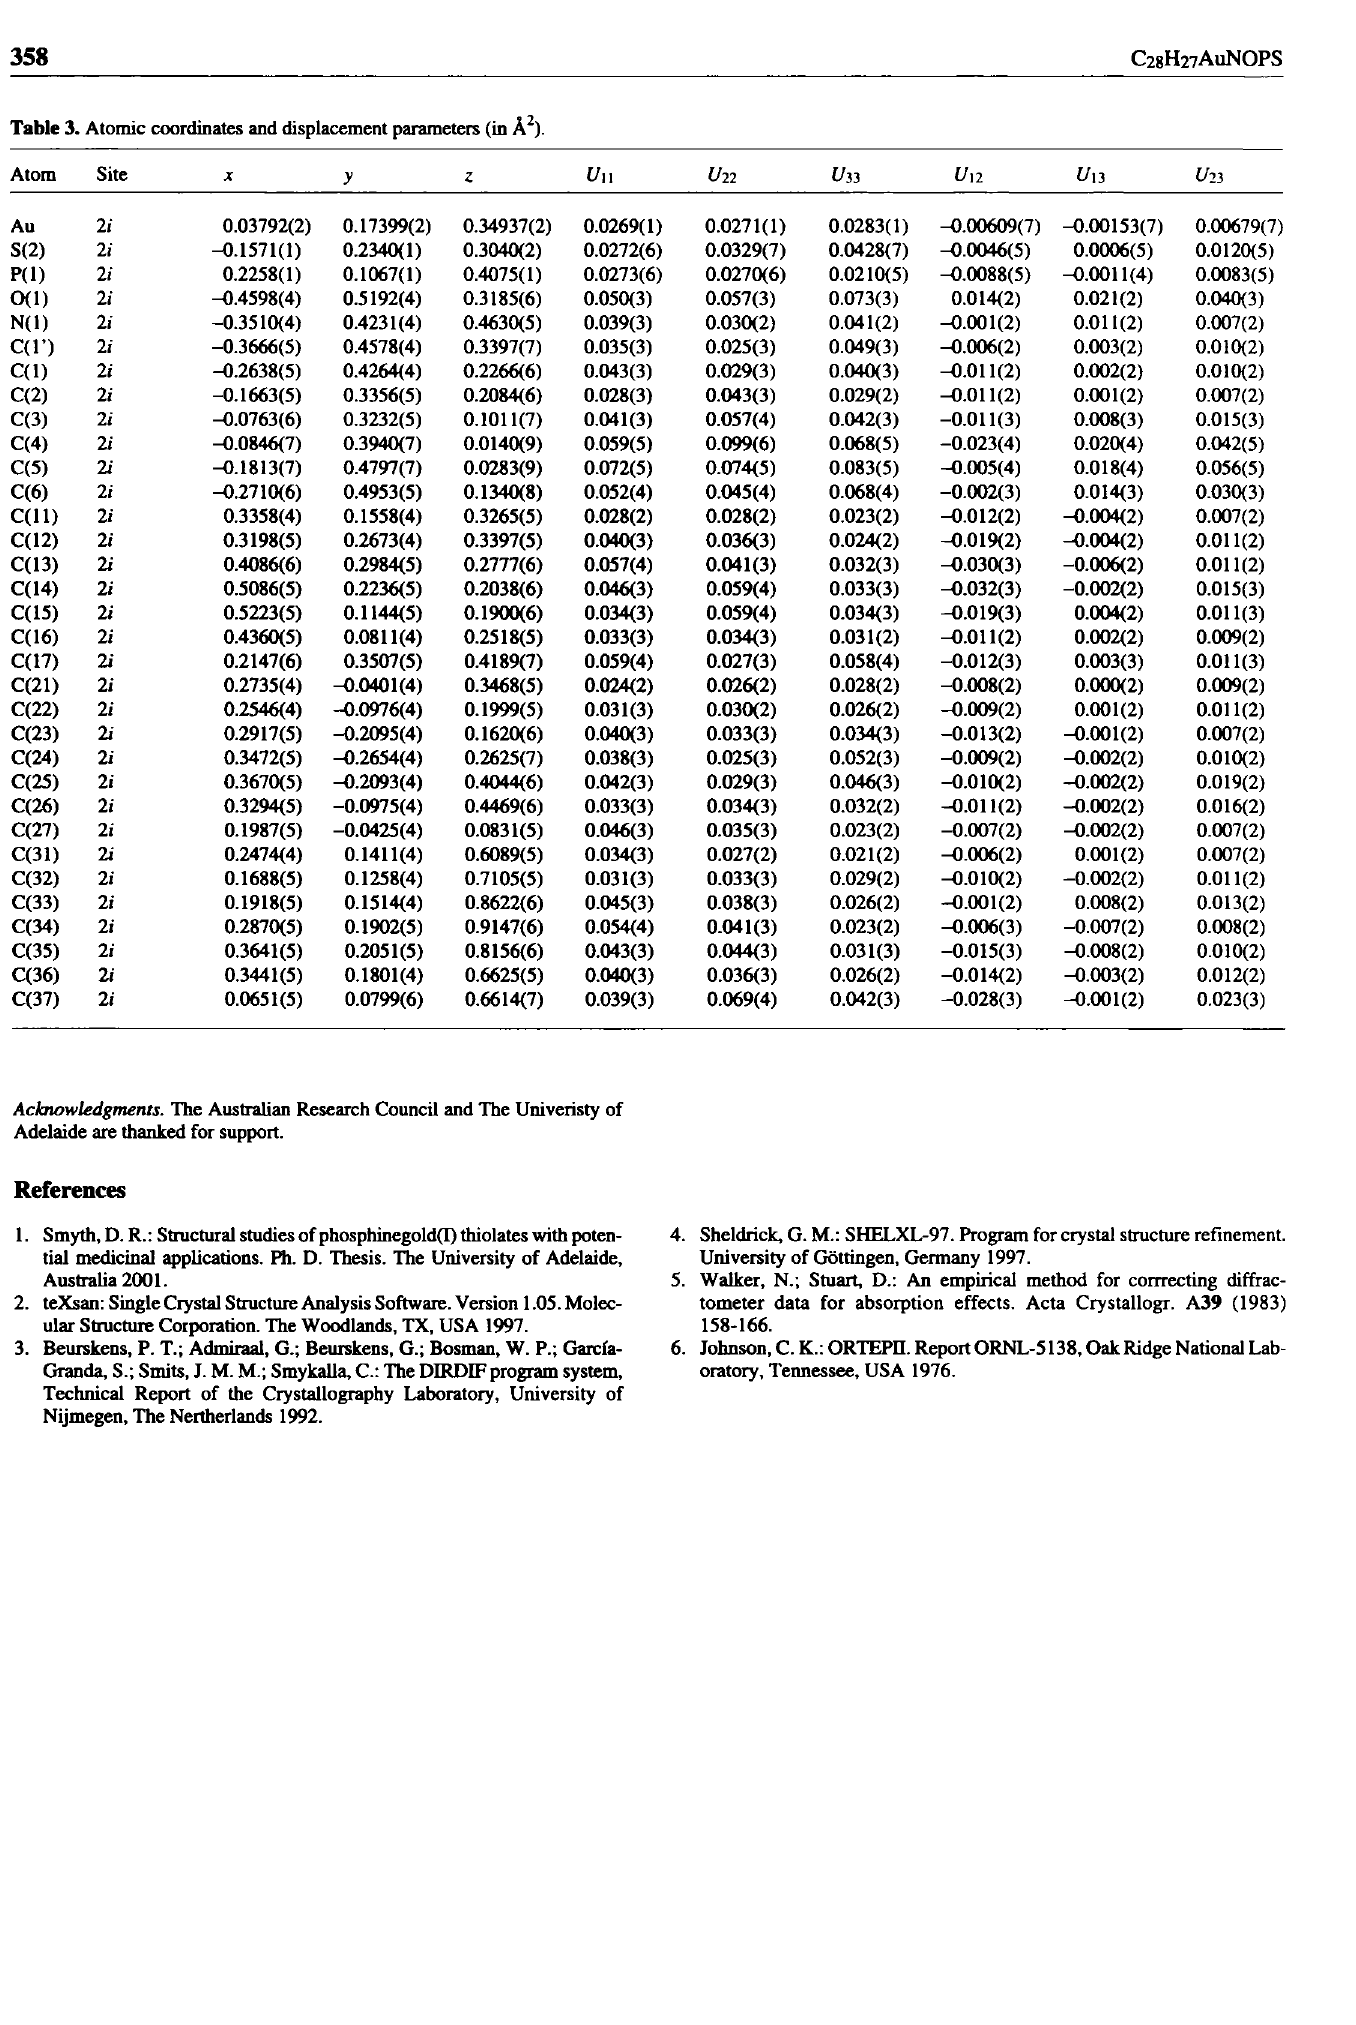
Table 3. Atomic coordinates and displacement parameters (in Â 2